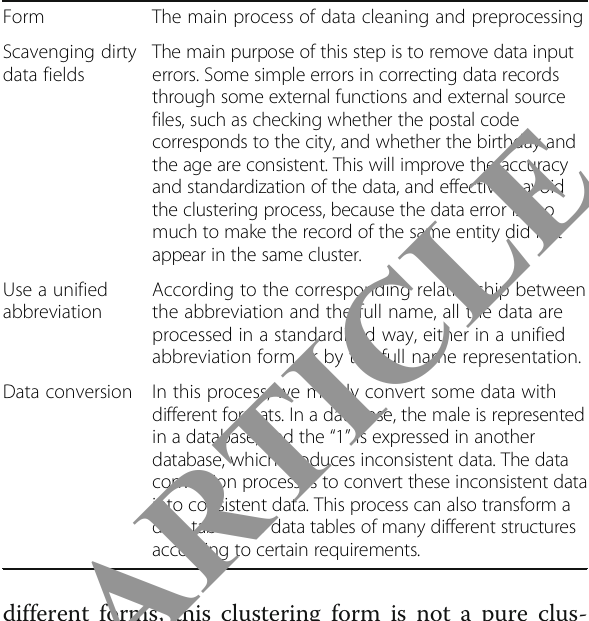
Table 1 The main process of data cleaning and preprocessing